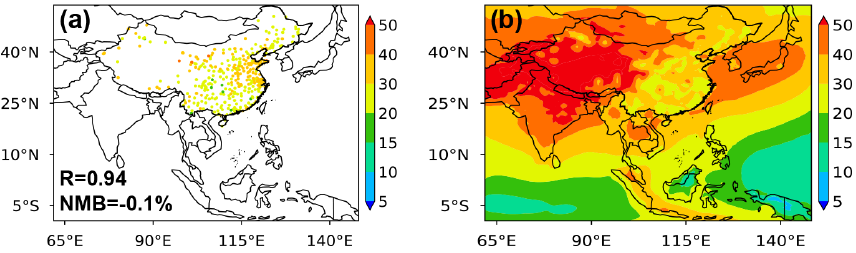
Figure 2. Spatial distributions of (a) observed near-surface O 3 concentrations across China and (b) assimilated O 3 concentrations over Asia in 2014–2019. Correlation coefficient ( R ) between observed and assimilated O 3 and the normalized mean bias (NMB = (cid:80) (Observed − Assimilated) / (cid:80) Assimilated × 100%) are given at the bottom left of panel (a)